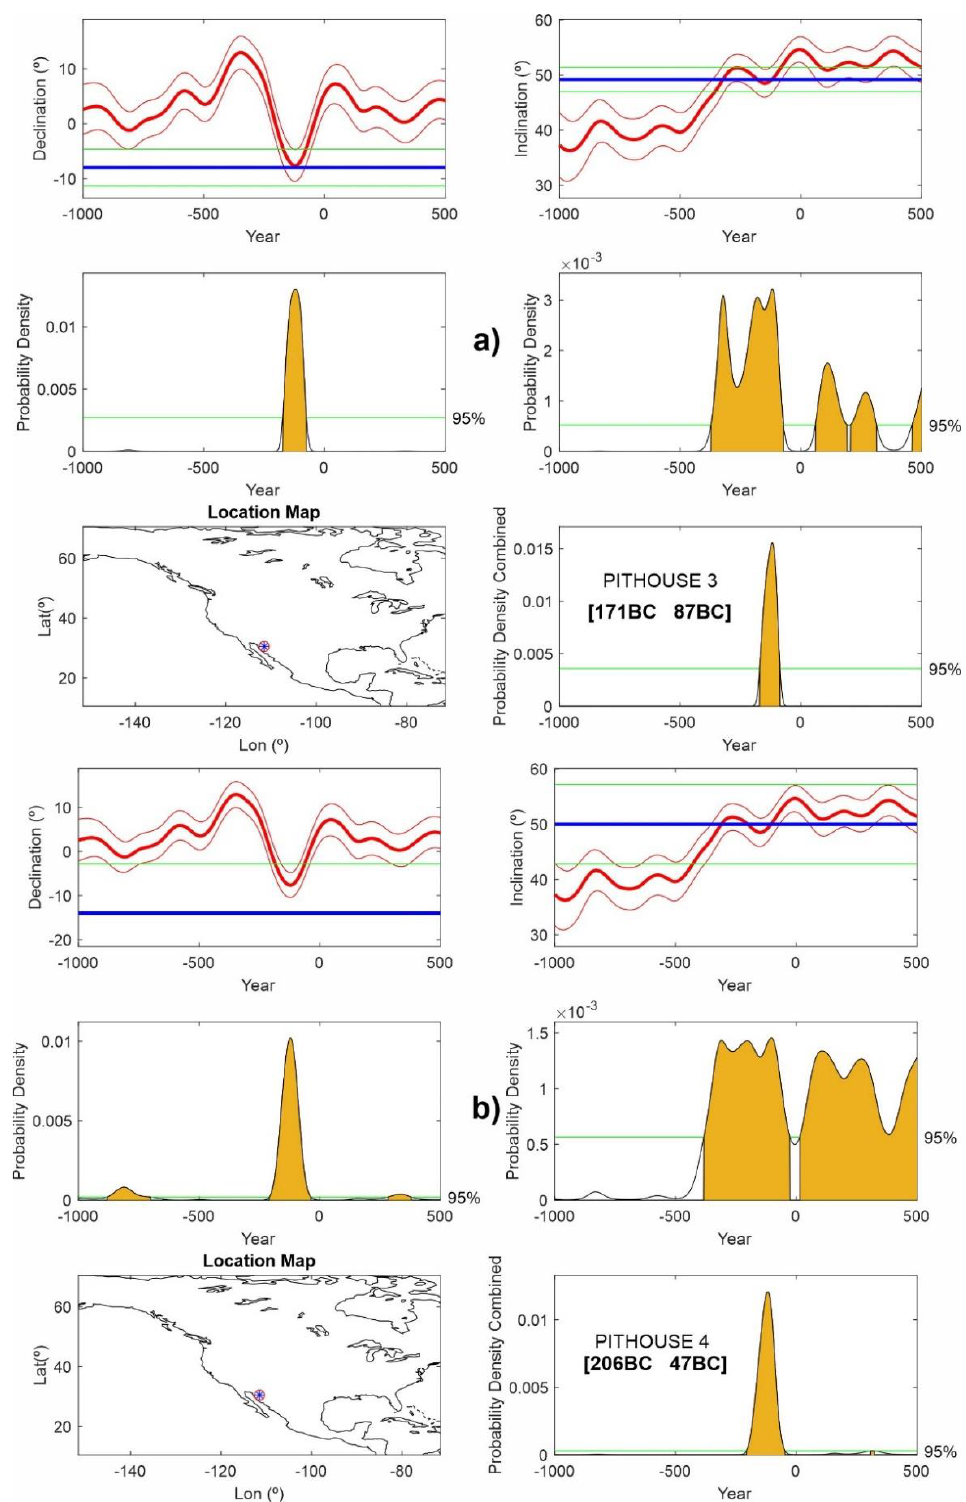
Figure 8. Archaeomagnetic dating using SHA.dif.14k global geomagnetic model [33,34] for Pit House 3 and 4.